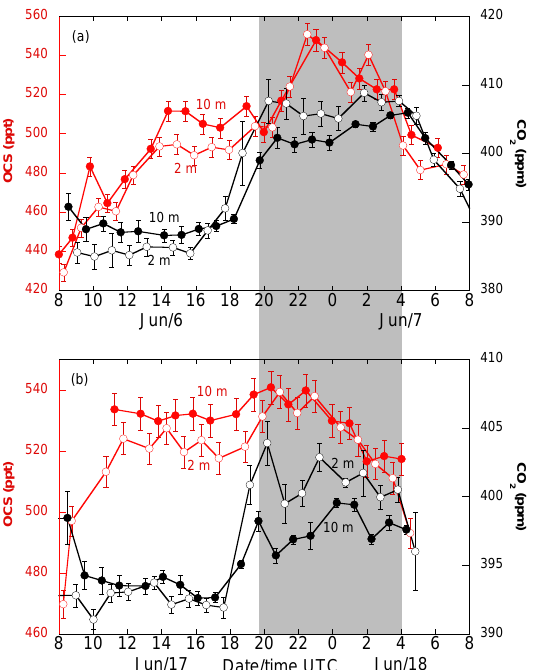
Figure 5. Time series plots showing diurnal variations in ambient OCS and CO 2 mixing ratios (displayed in red and black, respec- tively) within and above the canopy (2 and 10m heights, circles and dots, respectively) at the O3HP site during two measurement periods in June 2012 (a, b) . The grey vertical band corresponds to nighttime. Error bars represent one standard deviation of mean CO 2 mixing ratios recorded by the PICARRO instrument, which alter- nated measurements between 2 and 10m heights on a half-hourly basis. OCS measurement repeatability is